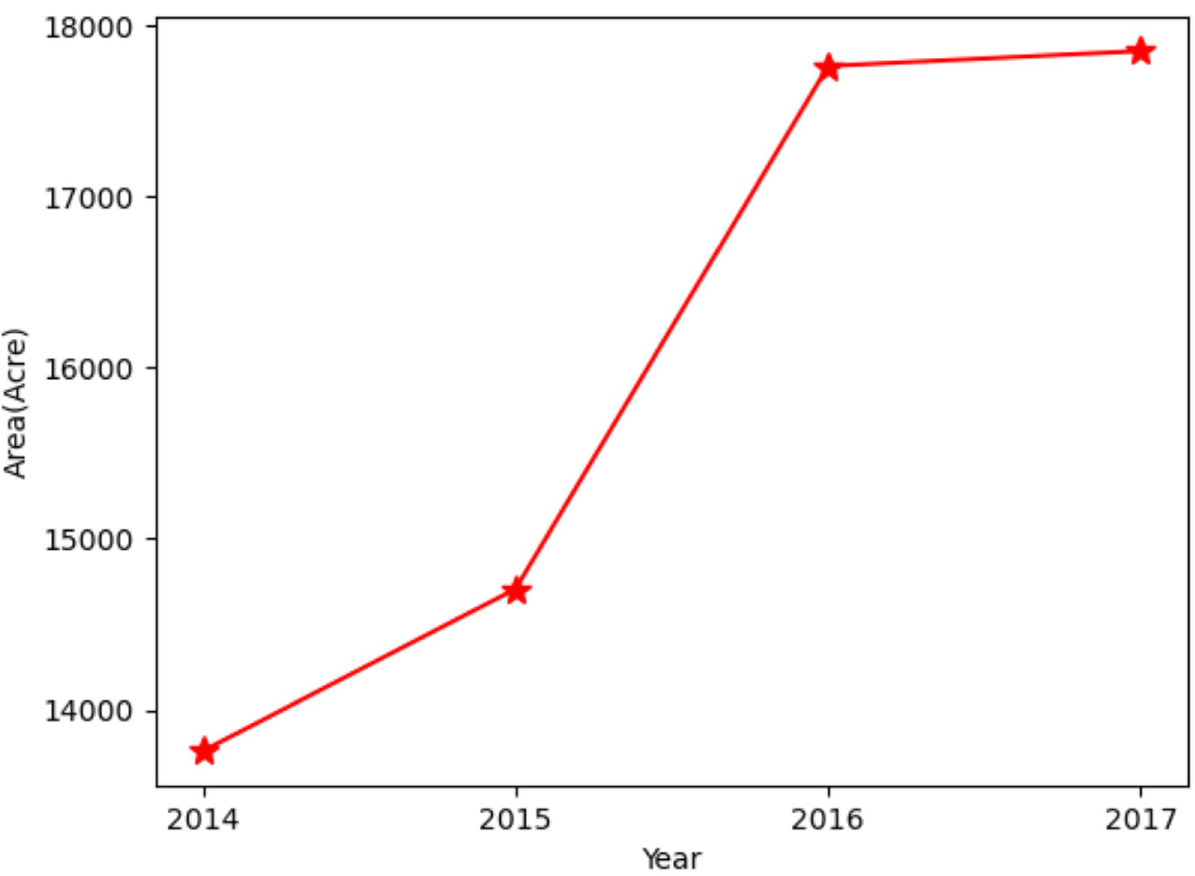
Fig 13. Area change from 2014 to